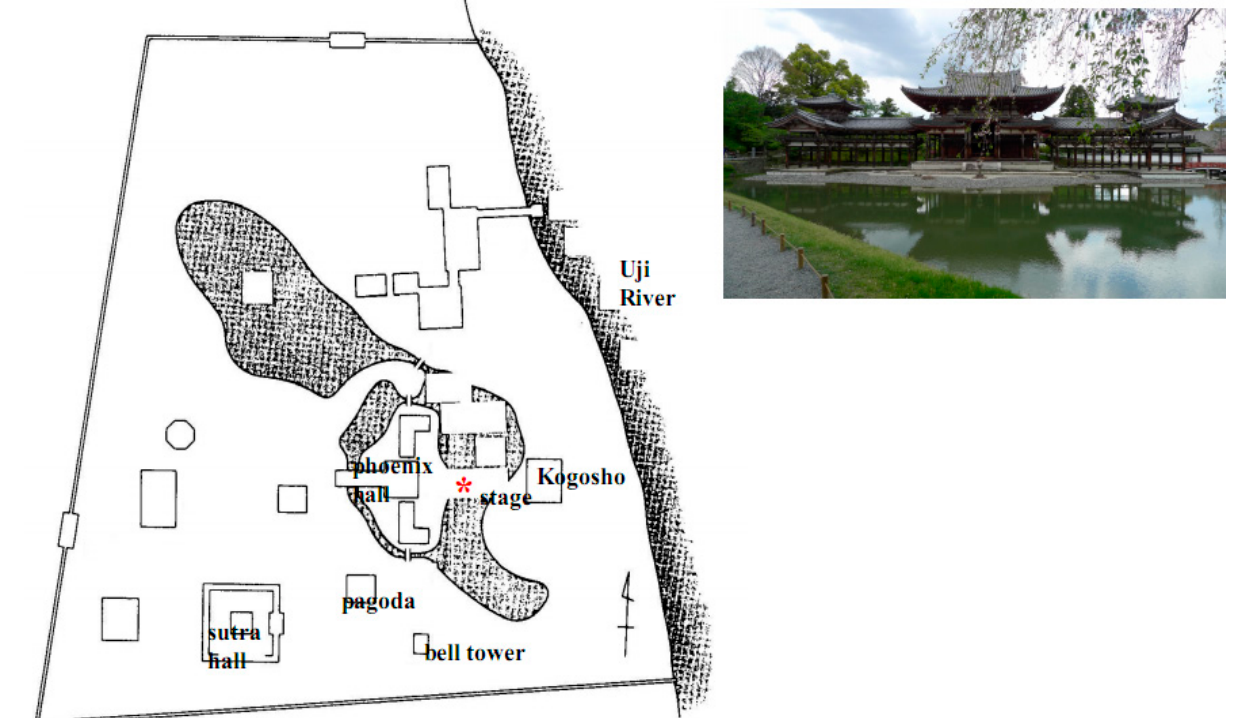
Figure 15. Byodo-in, the Phoenix Hall and Little Imperial Palace